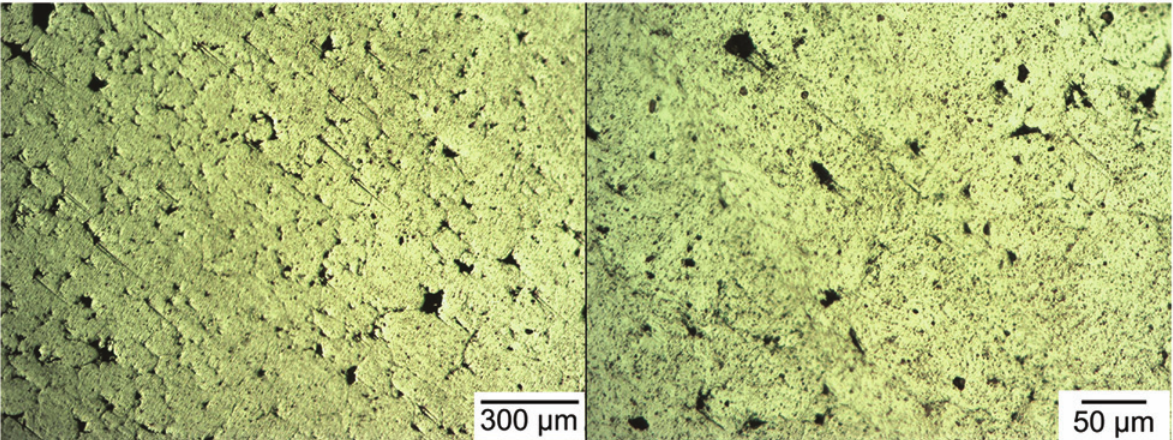
/Al nanocomposite at low magnification; (B) MgB 2